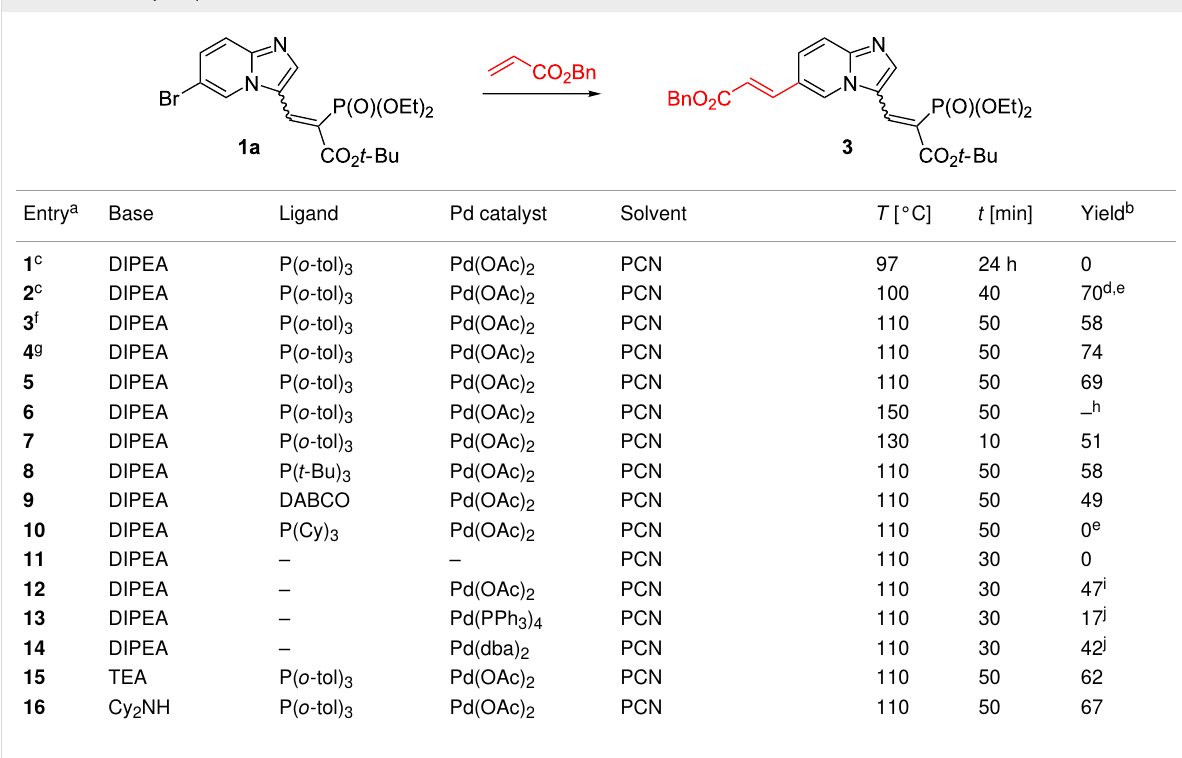
Table 1: Summary of optimization studies.